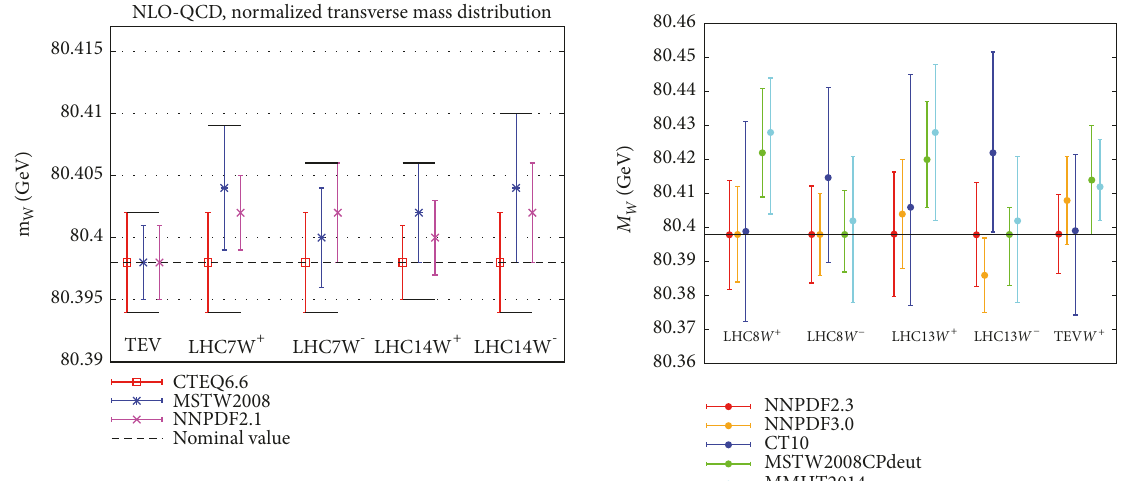
Figure 5: Shifts induced on 𝑚 𝑊 by the choice of different PDF sets, obtained through a template-fit performed on the transverse mass 𝑚 𝑇 (left) and the lepton 𝑝 𝑇 (right) observables (left figure from [16], right figure from [17]).